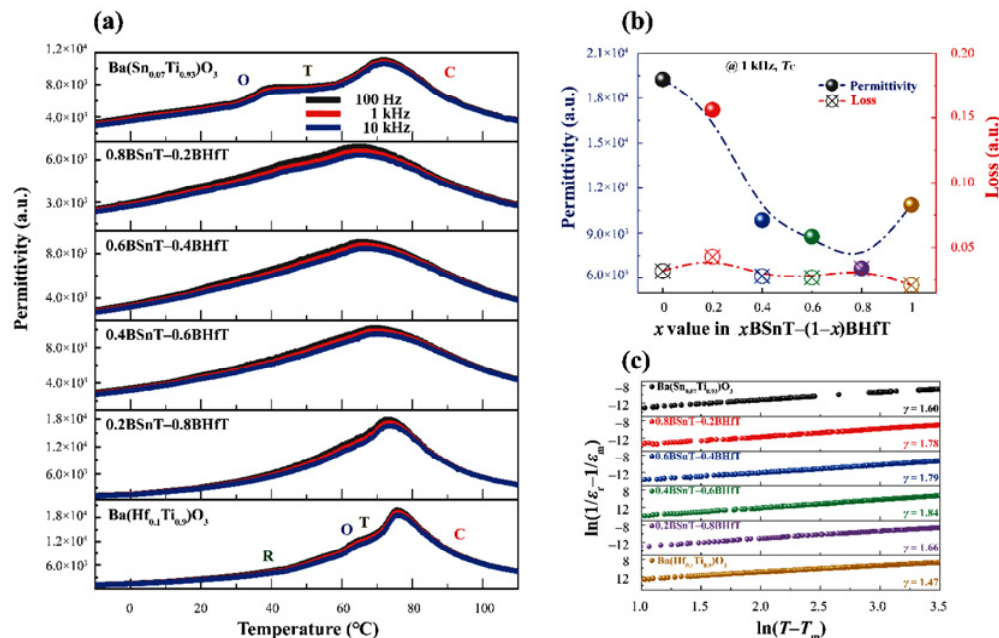
Fig. 2 (a) Dielectric constant as a function of temperature and frequency for x BSnT–(1 − x )BHfT ceramics. (b) Maximum values of permittivity and their corresponding dielectric losses for ceramics with different x . (c) Logarithmic plots of reciprocal permittivity as a function of temperature for ceramics with different x .